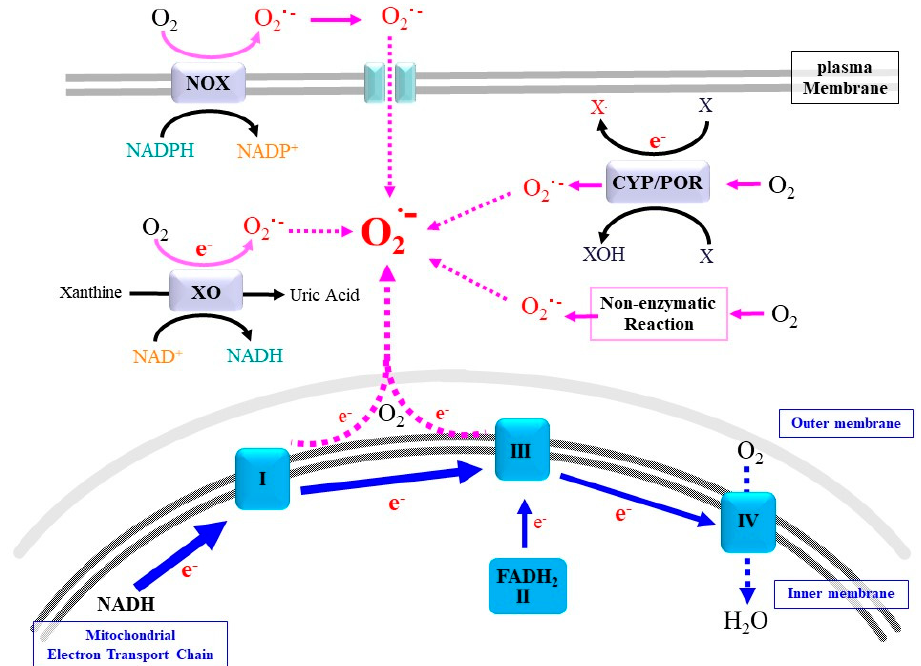
Figure 1. Representative electron sources of superoxide. While mitochondrial ETC is the major source for superoxide (O 2. − ), many enzymes, such as NADPH oxidase (NOX), xanthine oxidase (XO), and cytochrome P 450 (CYP)/cytochrome P 450 reductase (POR), convert molecular oxygen to superoxide either as a main product or as a byproduct during oxidation of a variety of compounds (X), such as benzene compounds, drugs, and steroid hormones. Superoxide is also produced non-enzymati-